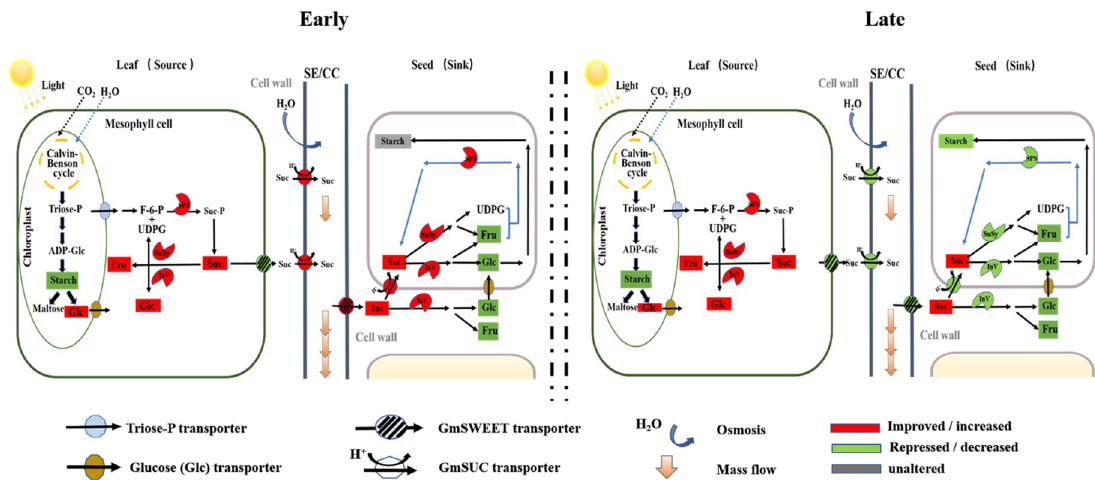
Figure 7. A comprehensive model of sucrose (Suc) metabolism and transport for sources (leaves) and sinks (seeds) in soybean plants under drought stress. Up-regulated elements under drought stress are shown with red boxes, down-regulated elements under drought stress are shown with green boxes, and unaltered elements are shown with gray boxes.